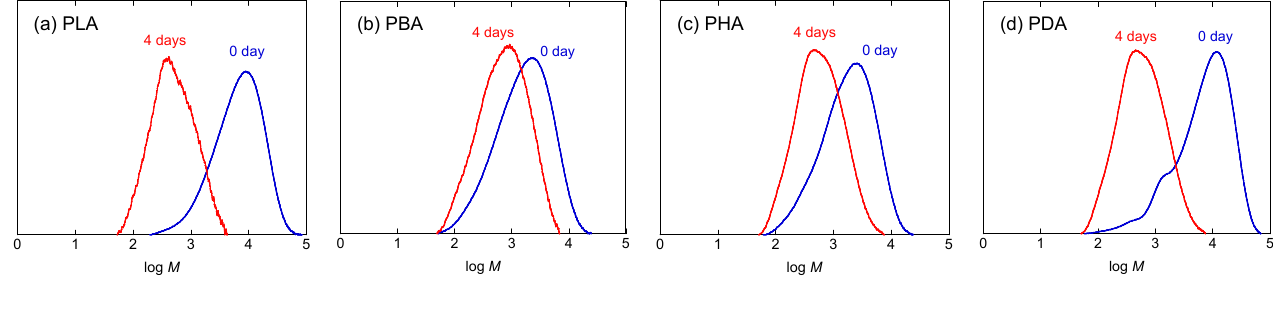
Figure 5. Molecular weight distribution curves of PLA ( a ), PBA ( b ), PHA ( c ), and PDA ( d ) before hydrolytic degradation (0 days) and after hydrolytic degradation at 80 °C for 4